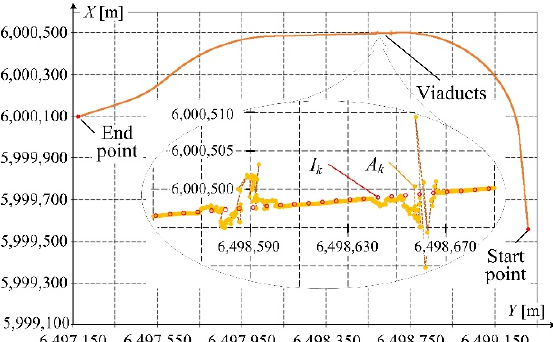
Figure 6. Results of post-processing of the signal from receiver A in 20 Hz mode and from INS – I k markers in 1 Hz mode.